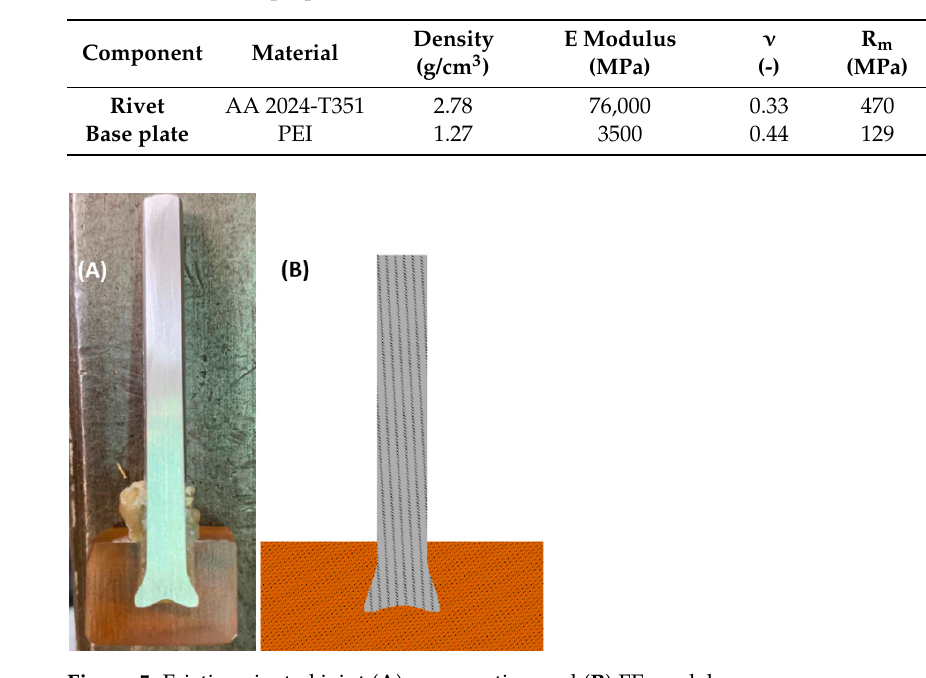
Table 1. Mechanical properties of materials used in FE model.